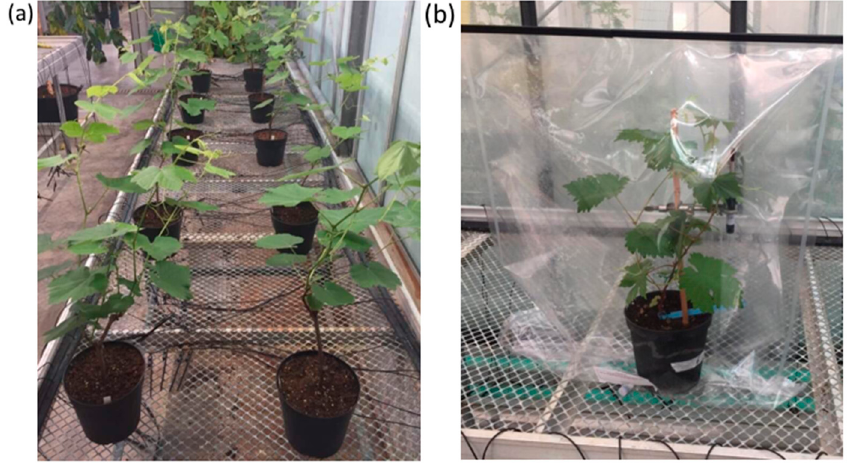
Figure 1. The cuttings of grapevines cv Chardonnay were grown in pots under greenhouse conditions ( a ). Representative image of grapevine in SKC (Tedlar gas sampling) bags to collect BVOCs (biogenic volatile organic compounds) in headspace air through fiber for SPME (solid phase microextraction) sampling technique ( b ).